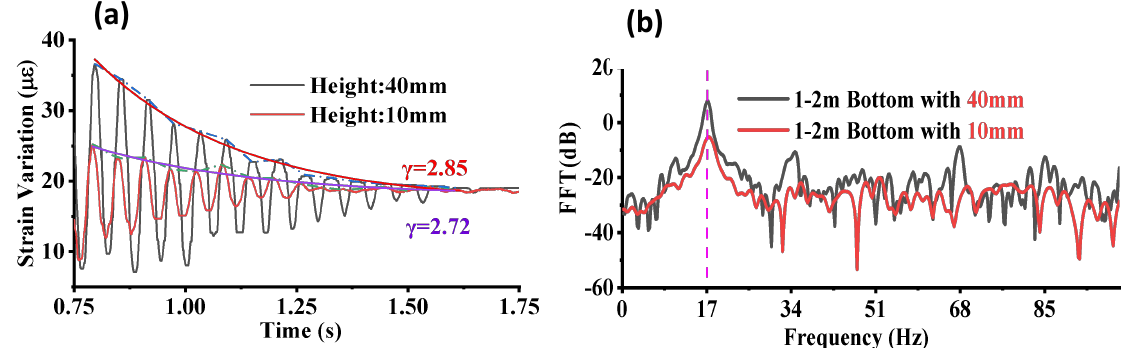
Figure 7. ( a ) The intrinsic damping parameter fitted in the damped oscillation section and ( b ) the natural frequency with different drop